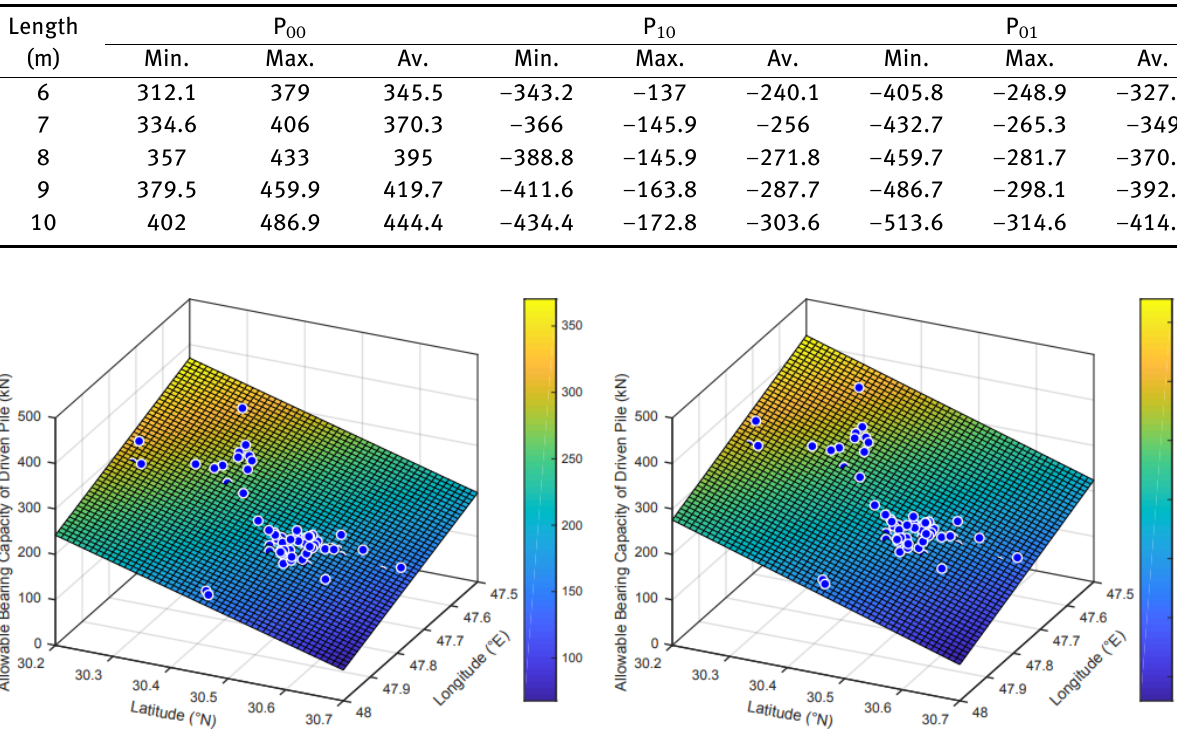
Figure 9: Surface defining the variation of the allowable bearing capacity of the driven pile having 9 m length